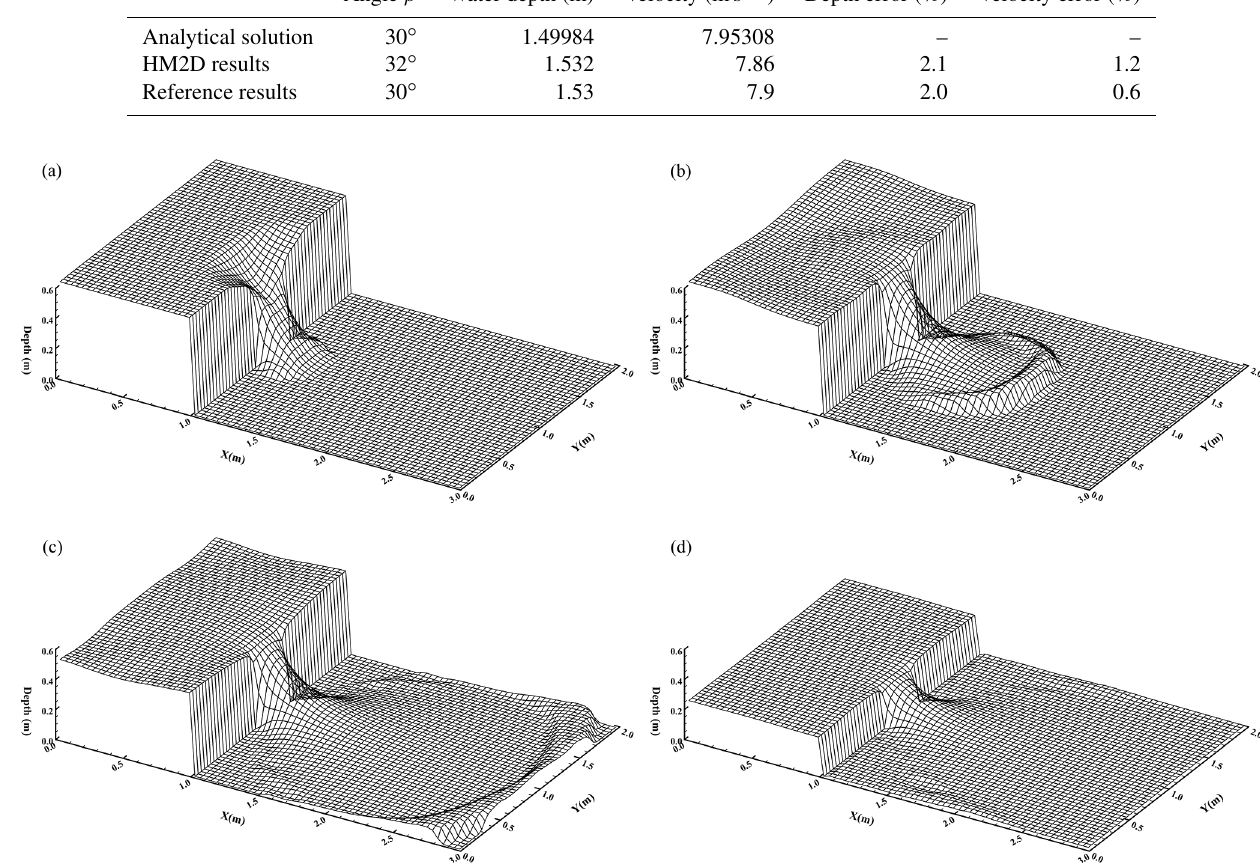
Figure 8. Snapshot of the water elevation for dam-break simulation: (a) t = 0 . 1s; (b) t = 0 . 5s; (c) t = 1 . 1s; (d) t = 5 . 0s.